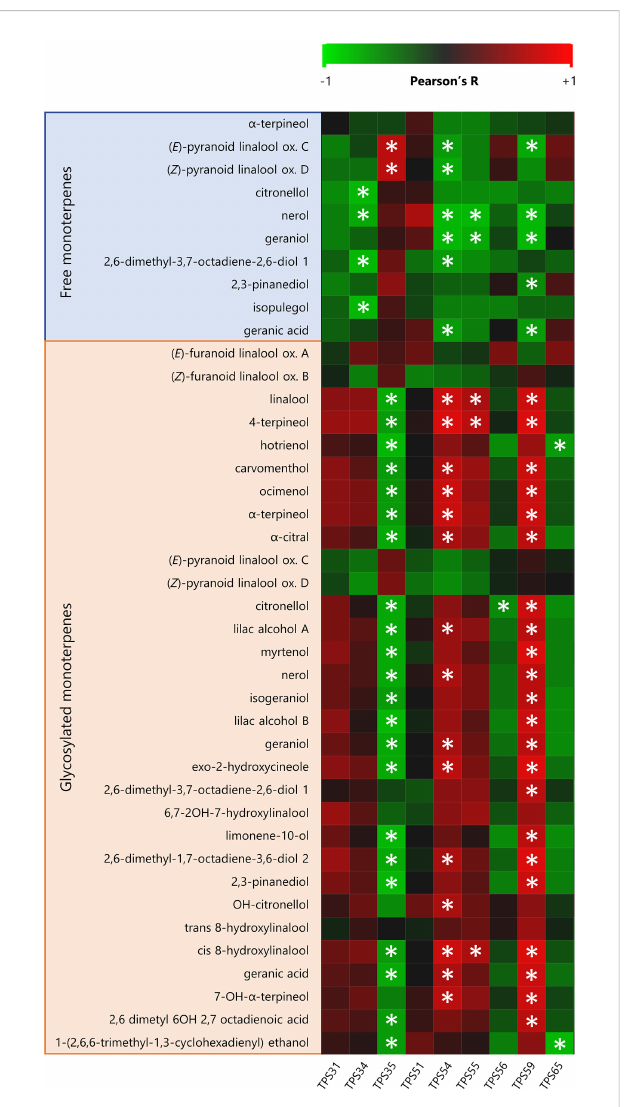
FIGURE 4 Pearson ’ s correlation heatmap between free and glycosylated berry monoterpenes and the relative TPSs expression in berries of Sangiovese grapevines ( Vitis vinifera L.) subjected to different irrigation regimes (FI, full irrigation from berry pea size to harvest; RDI-1S and RDI-1M, severe and moderate water de fi cit applied from berry pea size to beginning of veraison; RDI-LS, water de fi cit applied during lag- phase; RDI-2S and RDI-2M, severe and moderate water de fi cit applied from beginning of veraison to harvest). Asterisks identify signi fi cant correlation (p<0.05).